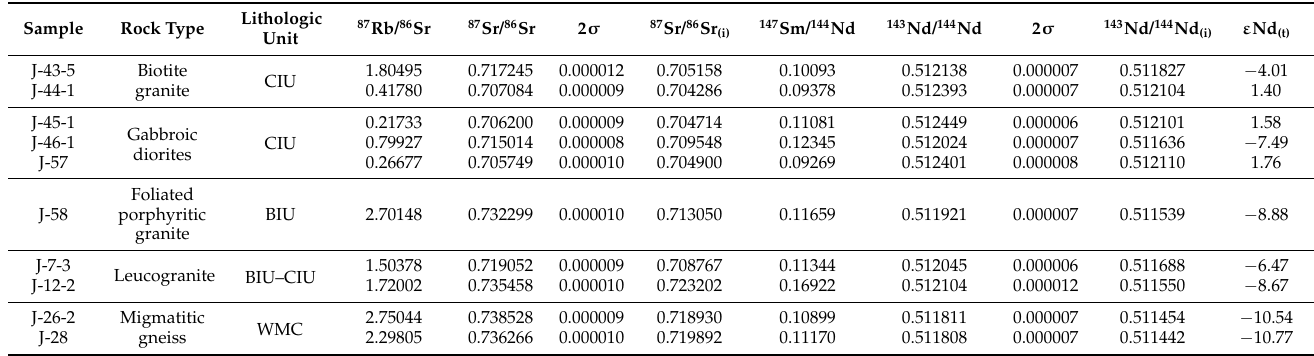
Table 1. Sr-Nd isotopic data for the BIU–CIU rocks in the TNIC, northern Victoria